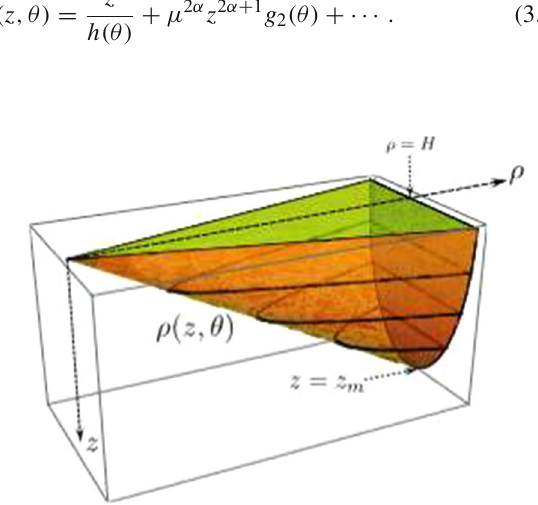
Fig. 1 Schematic figure of the RT extension of the kink (green region) into the bulk